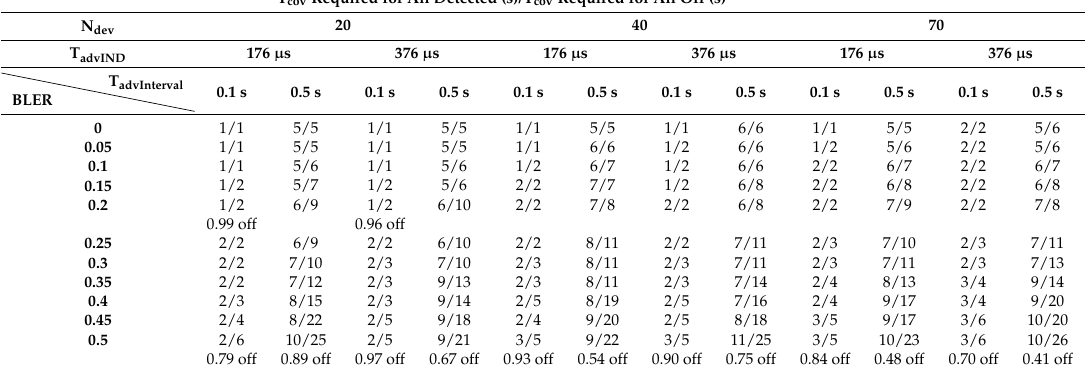
Table 5. Interrupted scannable undirected advertisement scheme . T cov required for detecting and stopping all the devices for one scanner ((x off) is the probability that all the devices becomes off in the T cov required to detect all of them).